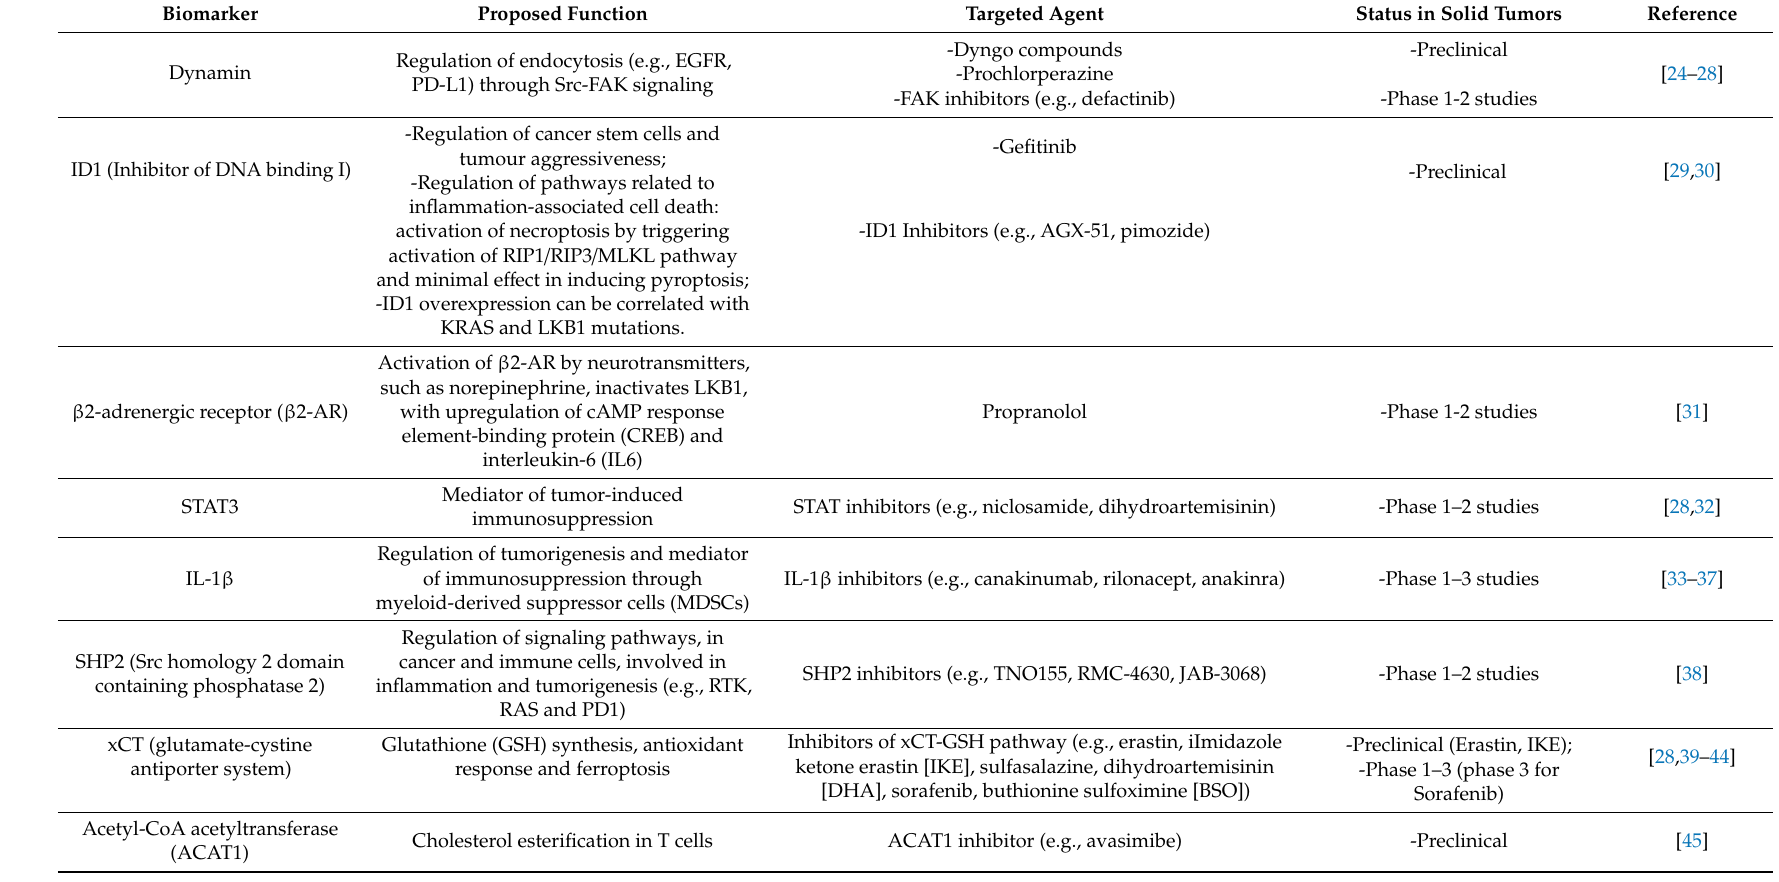
Table 2. Selected biomarkers for novel potential therapeutic strategies to improve PD-1 / PD-L1 inibitor e ffi